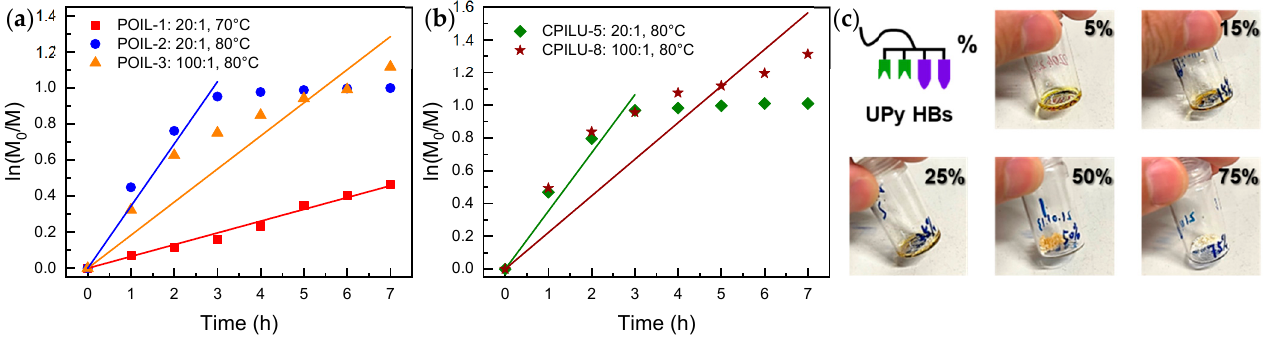
Figure 1. Kinetic plots of RAFT ( a ) homopolymerizations of ILA under the conditions: [ ILA ]/[DBTTC] = 20:1 at 70 °C (red square), [ ILA ]/[DBTTC] = 20:1 at 80 °C (blue circle), and [ ILA ]/[DBTTC] = 100:1 at 80 °C (orange triangle); ( b ) copolymerizations of ILA with UPyA under the conditions: [ ILA + UPyA ]/[DBTTC] = 20:1 at 80 °C (green rhombus) and [ ILA + UPyA ]/[DBTTC] = 100:1 at 80 °C (brown star); and ( c ) photos of the copolymers CPILU-y with various contents of UPy moieties.